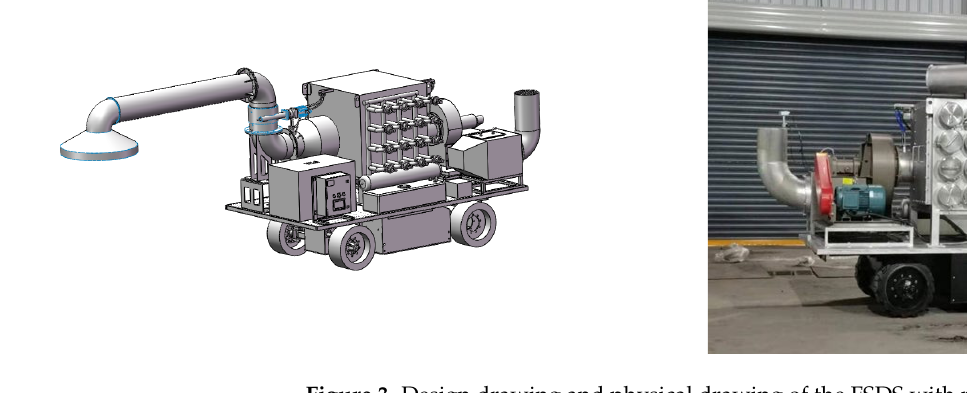
Figure 3. Design drawing and physical drawing of the FSDS with mobile device. Table 2. The design parameters of the FSDS with mobile device.